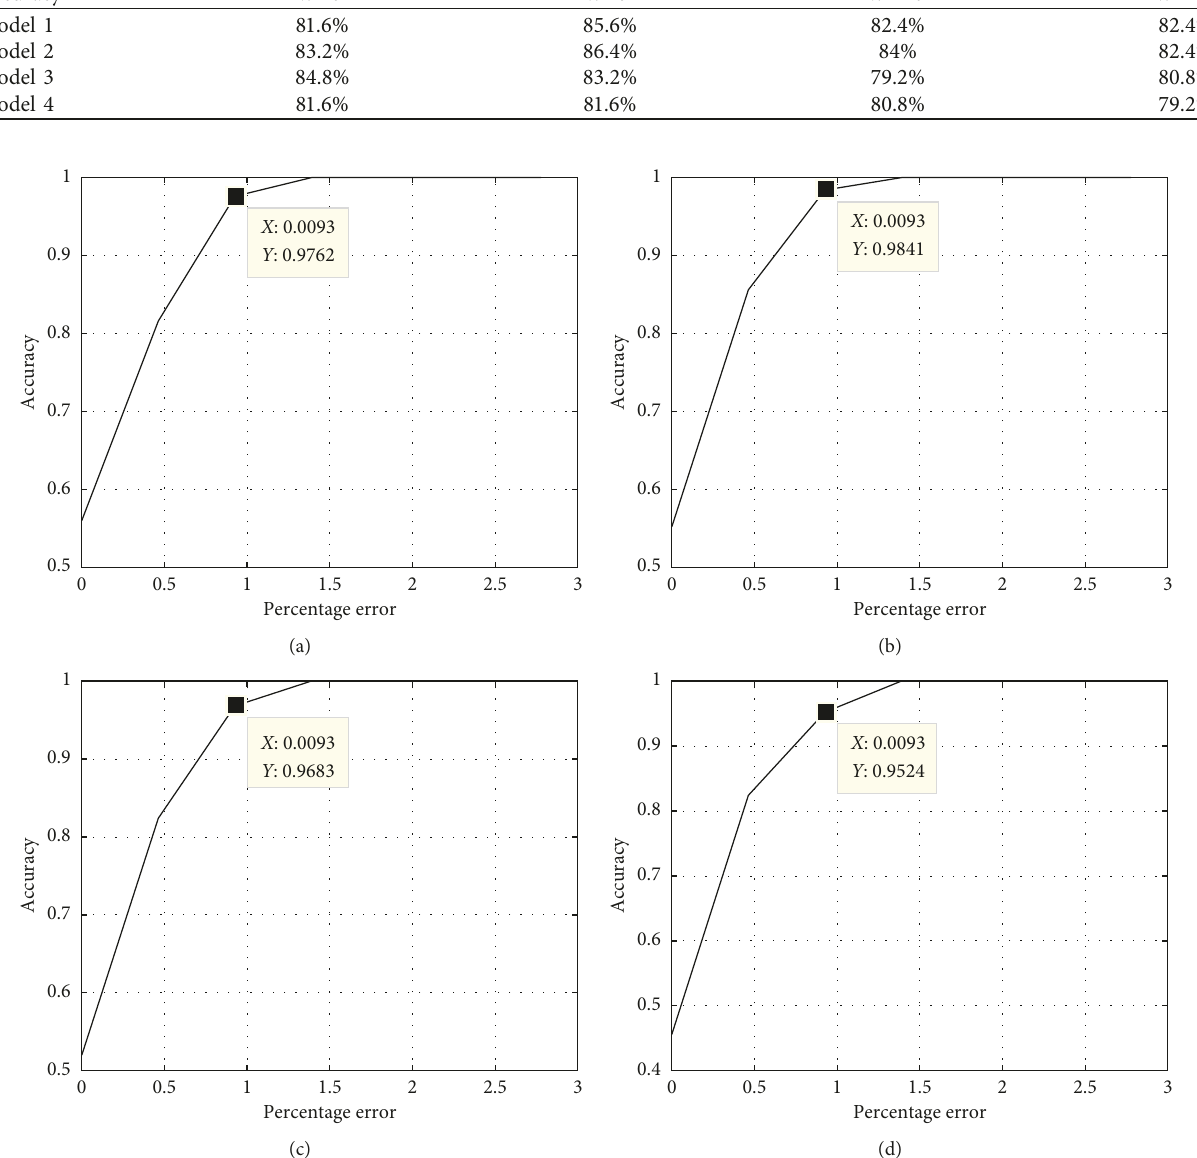
Table 3: Recognition accuracy for different values of k and percentage error of broken wires is 0.49%.